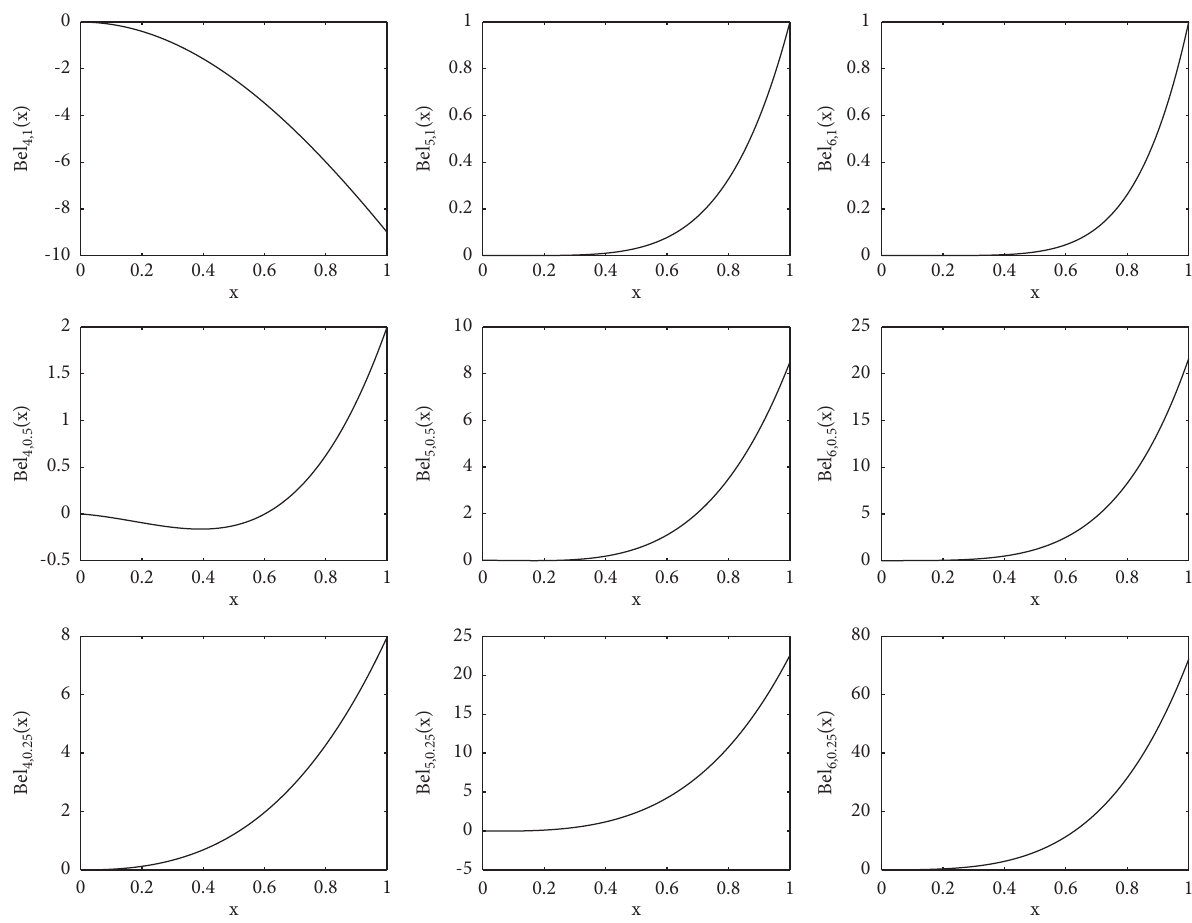
Figure 1: The shapes of Bell polynomials Bel